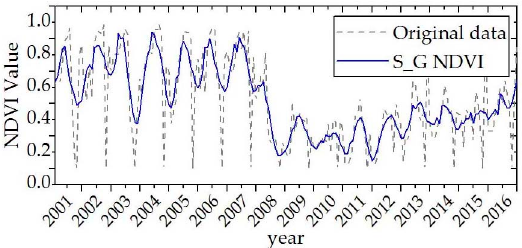
Figure 4. The minimal change in fitted values of an NDVI (Normalized Difference Vegetation Index) pixel in time series near the Huojizai Village of Maoxian County before and after the 12 May 2008 Wenchuan Earthquake. In Figures 4–6, the broken grey lines are the original MODIS-NDVI data and the solid blue lines are the fitted data.